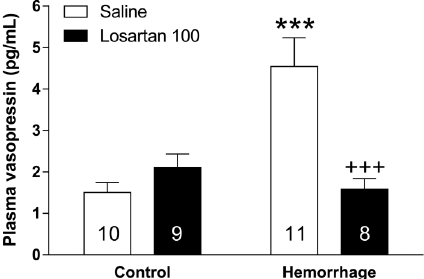
Figure 3. Losartan administration reverses the effects of hemorrhage on arginine vasopressin (AVP) secretion. This result indicates that angiotensin II AT1 receptor signaling is necessary for hemorrhage-induced AVP secretion. Data are reported as means ± SE. ***P o 0.001 vs control-saline, +++ P o 0.001 vs hemorrhage-saline (ANOVA). Numbers in columns indicate the number of